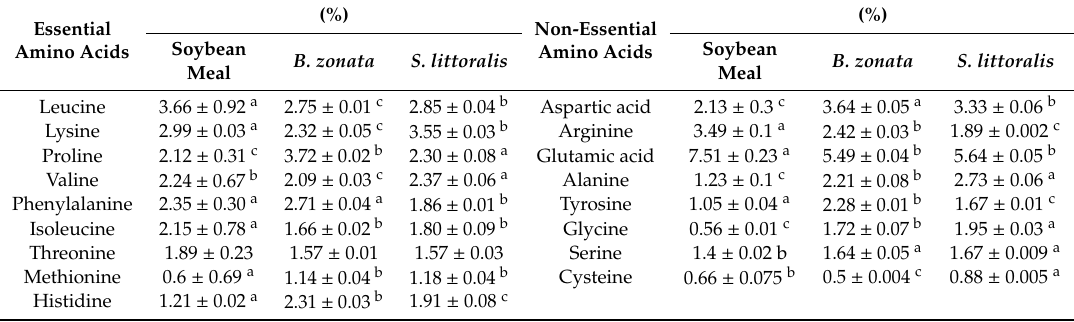
Table 3. Relative amino acid contents in soybean, B. zonata and S. littoralis meals in